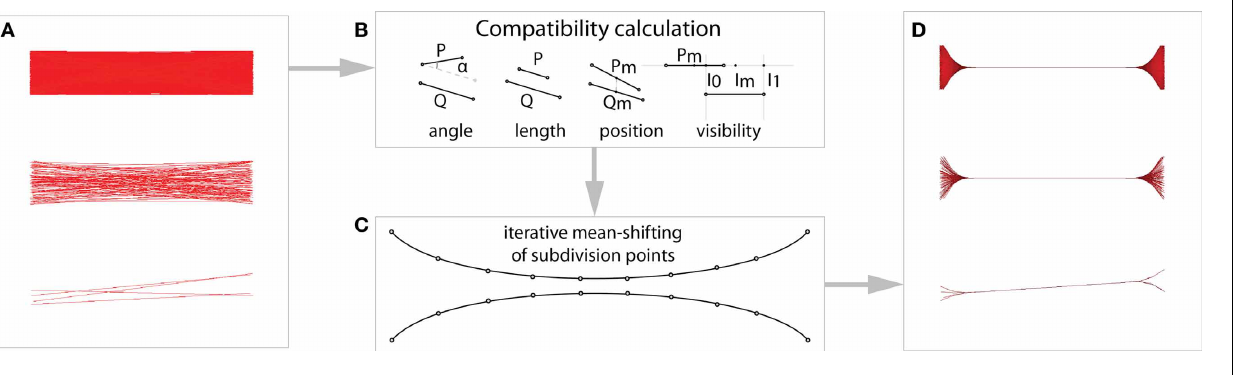
iteratively subdivides the connexels, and shifts compatible subdivision points toward their common mean. (D) Using a mean-shift has the advantage of bundling connexels with different density equally, and makes our method applicable to different datasets with the same default